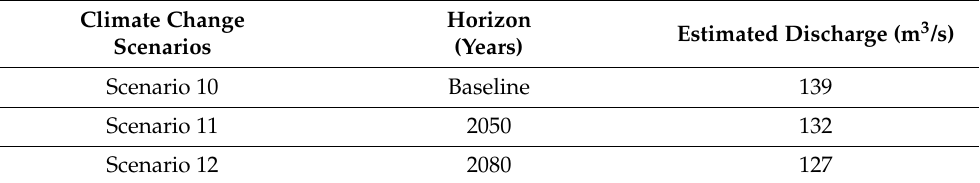
Table 4. Climate change projections for the Petite-Nation River watershed using a return period of 20 years for the baseline and the 2050 and 2080 horizons (RCP 8.5).